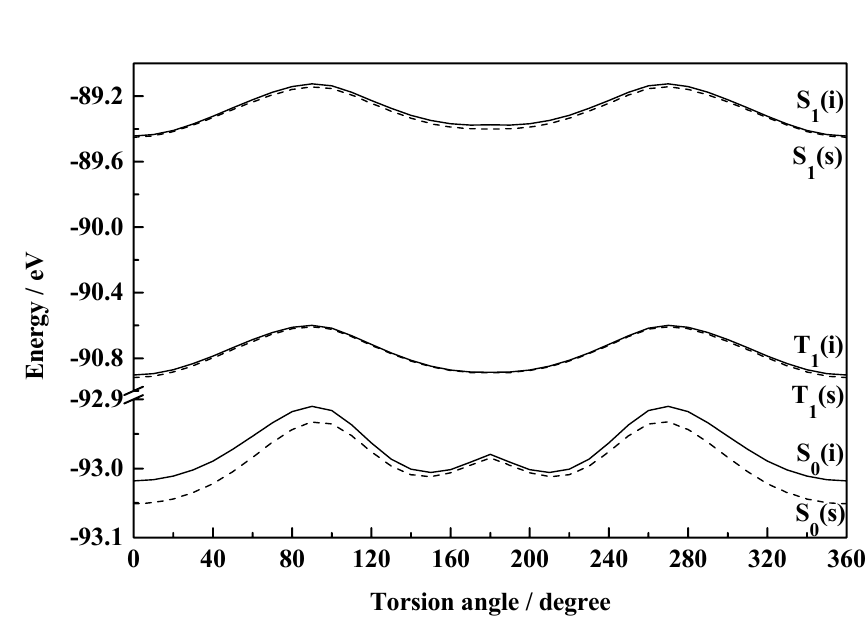
Figure 4. Plot of total molecular energy as a function of torsional angle (2-1-7-8) in S states of HPO (i, isolated; s, solvated in